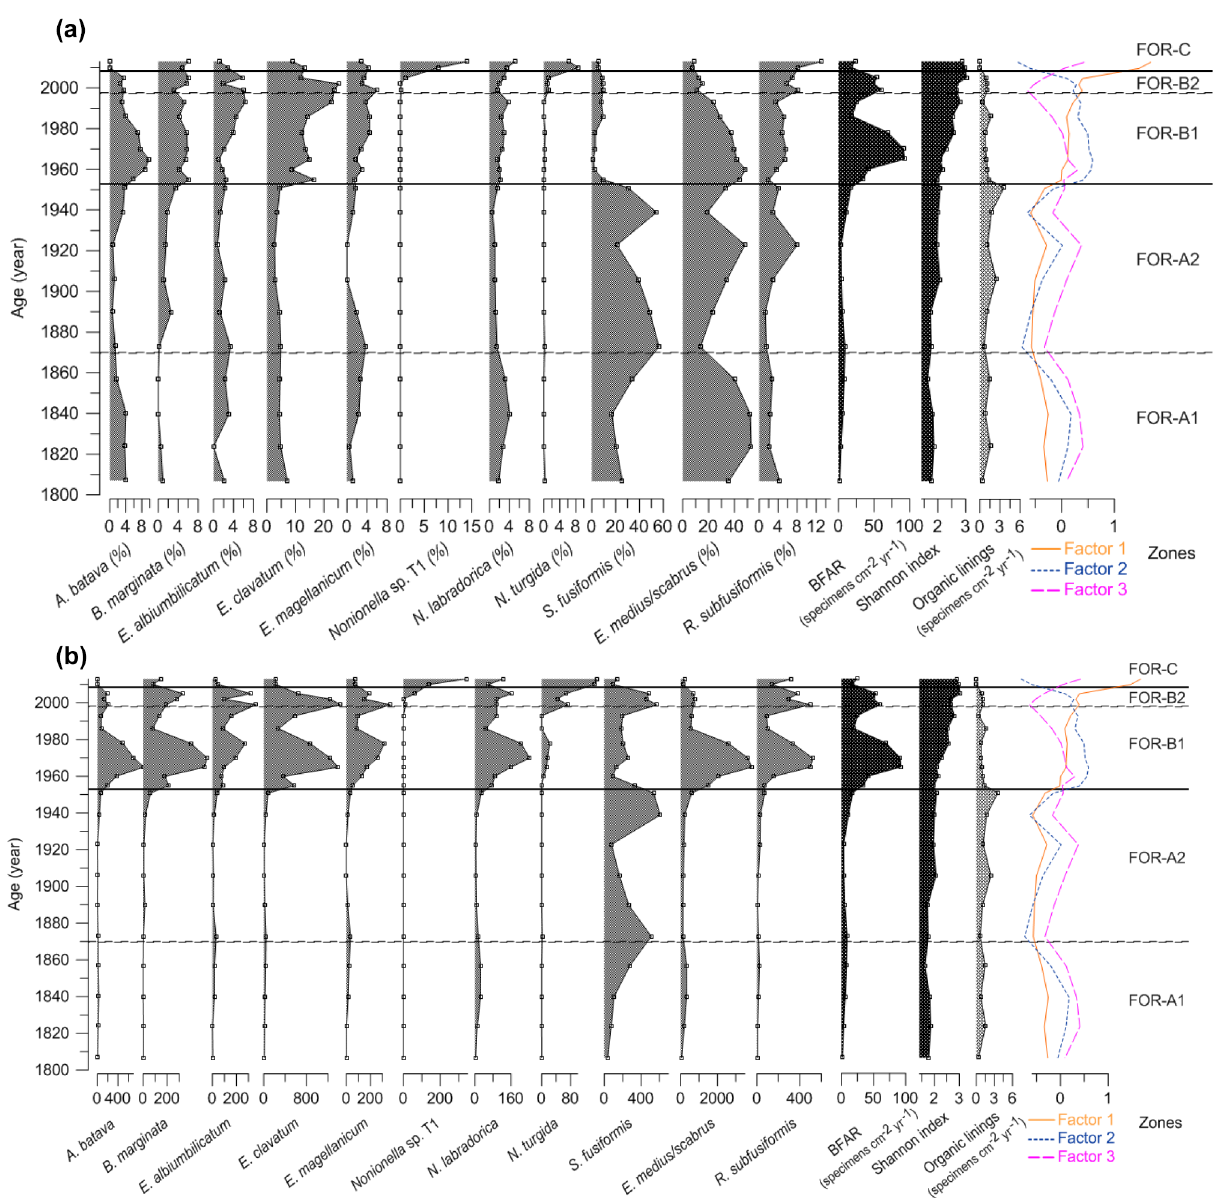
Figure 5. (a) Relative abundances (%) of the foraminiferal major species (>5%), benthic foraminiferal accumulation rate (BFAR, spec- imenscm − 2 yr − 1 ), Shannon index, organic linings (specimenscm − 2 yr − 1 ), and factors from the correspondence analysis. (b) Benthic foraminiferal accumulation rates (specimenscm − 2 yr − 1 ) of the major species (>5%), BFAR (specimenscm − 2 yr − 1 ), Shannon index, or- ganic linings (specimenscm − 2 yr − 1 ), and factors from the correspondence analysis. Foraminiferal zones based on cluster and correspon- dence analysis. Note the different scale on the x